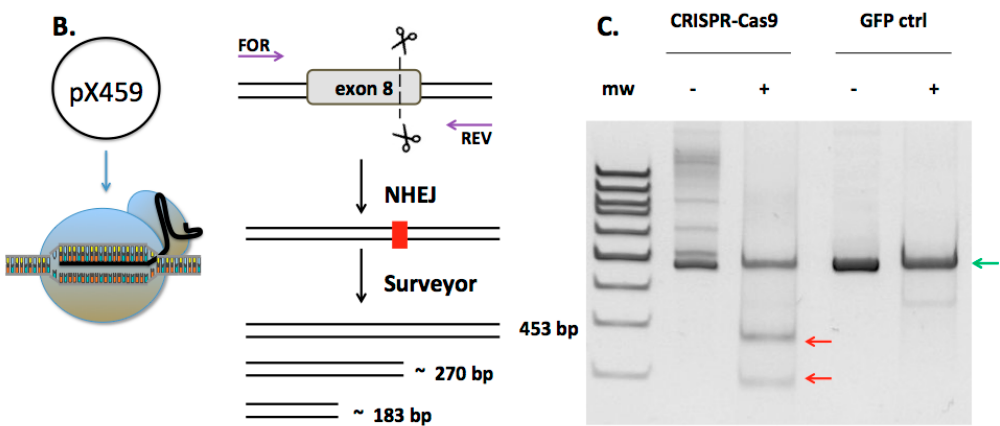
Figure 1. FANCD1 gene and CRISPR/Cas9 reagent design. ( A ) FANCD1 genomic architecture with causative mutations shown with red arrows. The full exon eight sequence is shown with the bases deleted in the 886delGT mutation highlighted in red. The CRISPR/Cas9 target sequence is shown in bold and underlined; ( B ) CRISPR/Cas9 construct and Surveyor assay. The pX459 DNA plasmid contains both the Cas9 and the gRNA that when delivered are expressed and form the functional complex. Following plasmid delivery, a region of the FANCD1 locus was amplified using the primers indicated by purple arrows (forward (FOR) and reverse (REV)). CRISPR/Cas9 activity causes gene repair by non-homologous endjoining (NHEJ; red box). The Surveyor enzyme cleaves hybridized heteroduplexes of modified and unmodified amplicons; ( C ) 293 cell Surveyor analysis. The cleavage products showing FANCD1 gene modification are shown with red arrows. GFP treated controls are at right. The green arrow shows the full-length amplicon. “+” = addition of Surveyor enzyme; “ − ” = no Surveyor enzyme; “mw” = molecular weight standards.